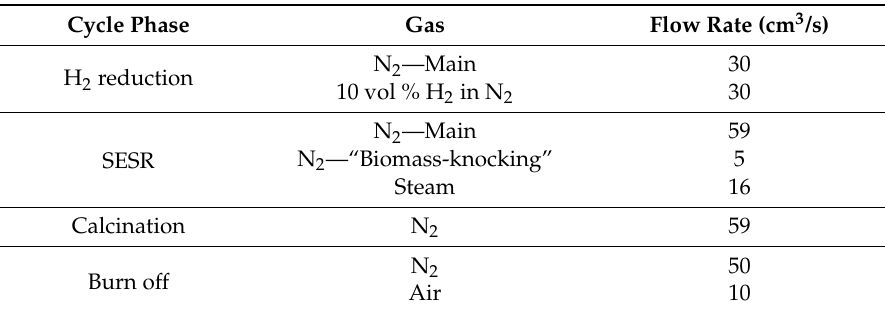
Table 3. Calibrated flow rates utilised during each cycle phase.